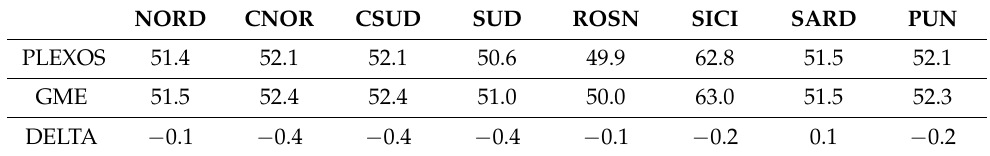
Table 2. Zonal prices and PUN in € of Plexos base simulation compared to the GME